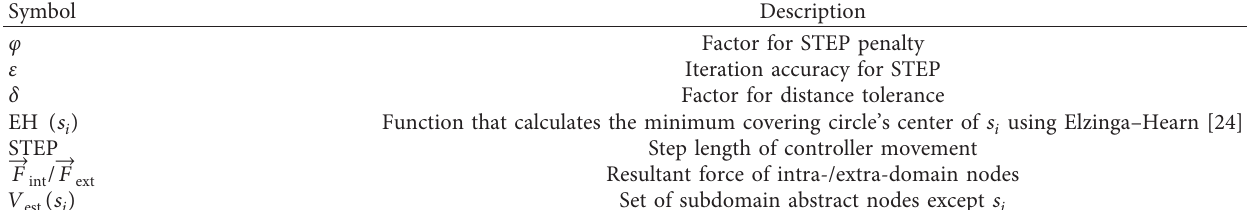
Table 3: Symbols of Algorithm 2.